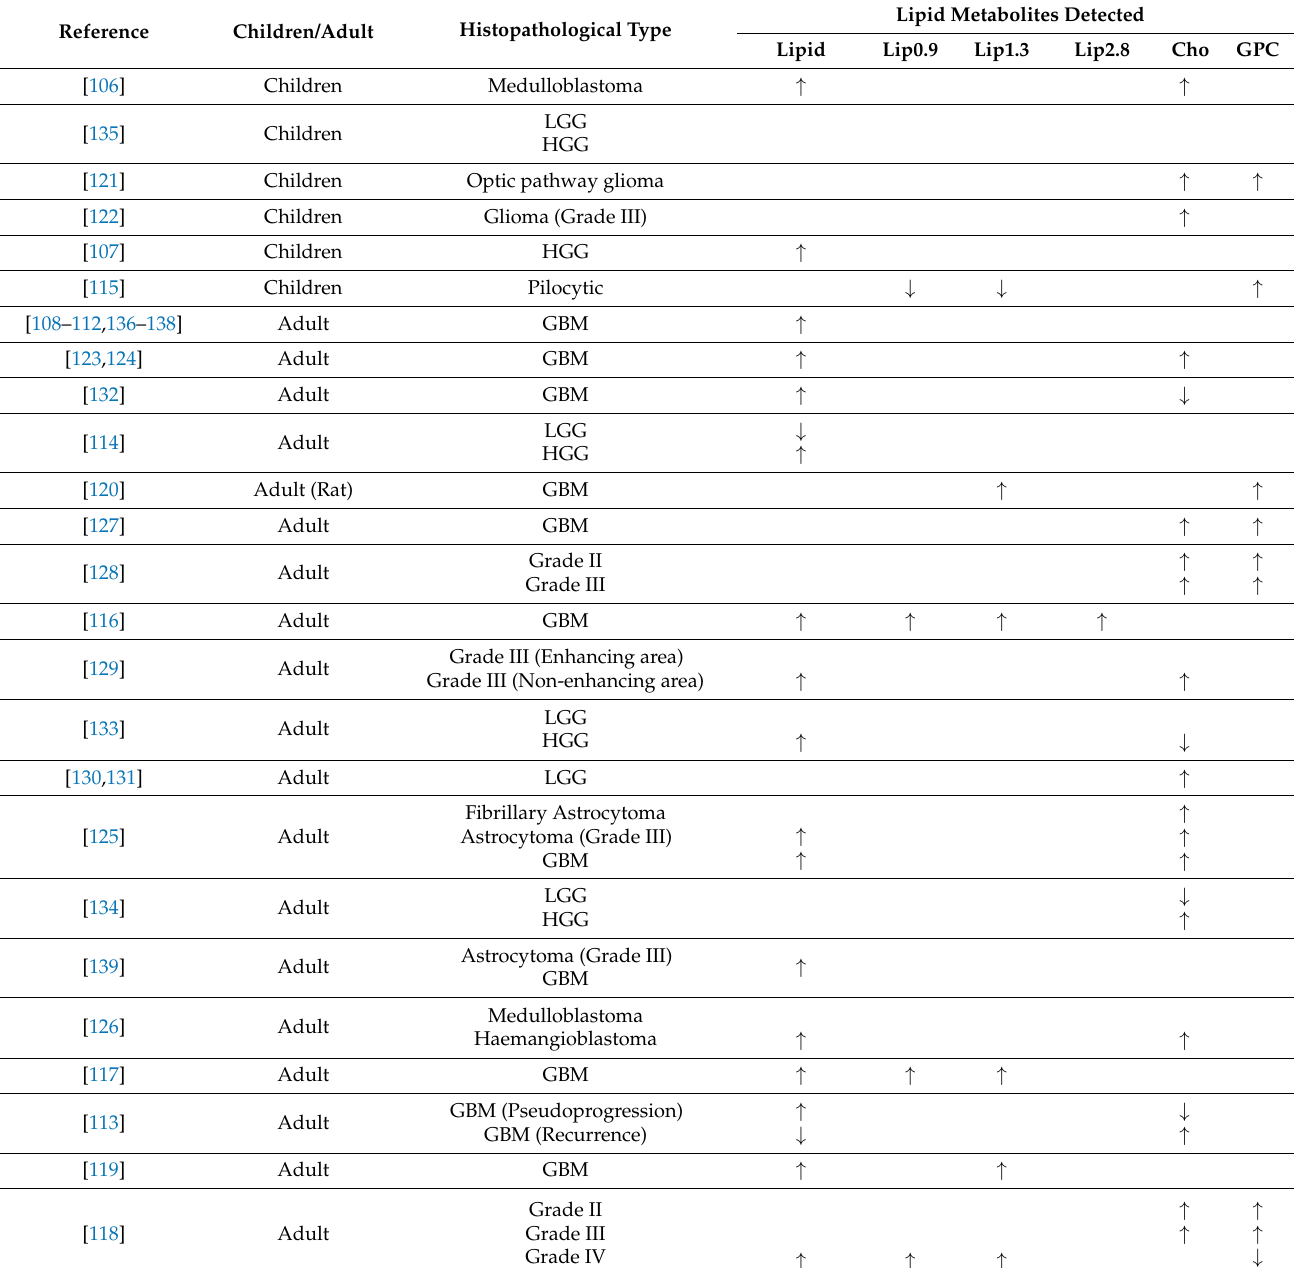
Table 3. Lipid MRS characteristics as detected in the form of signal loss ratio (SLR), lipid fraction, and lipid spectroscopic signals of different glioma